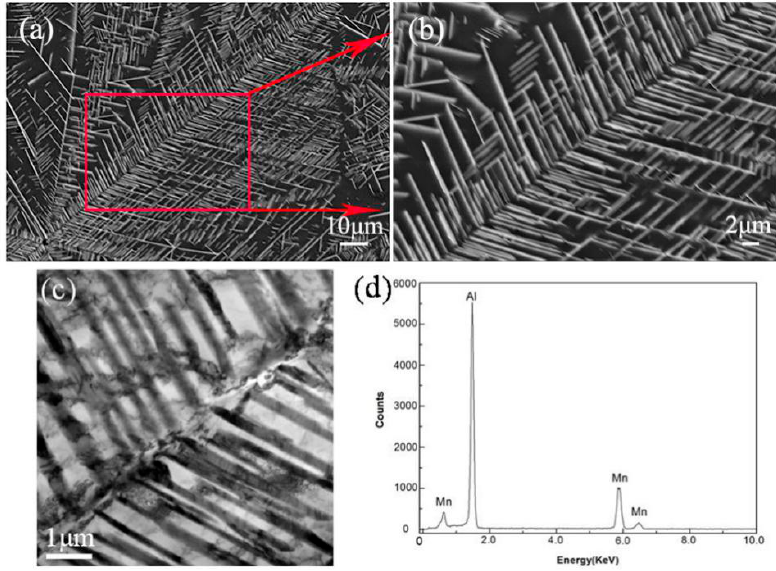
Figure 8. Dendrite microstructure at the center of the cross-section of the cylindrical sample in suction casting Al–8 wt.% Mn alloys: ( a ) SEM BSE; ( b ) SEM BSE; ( c ) TEM BF; ( d ) TEM EDS.